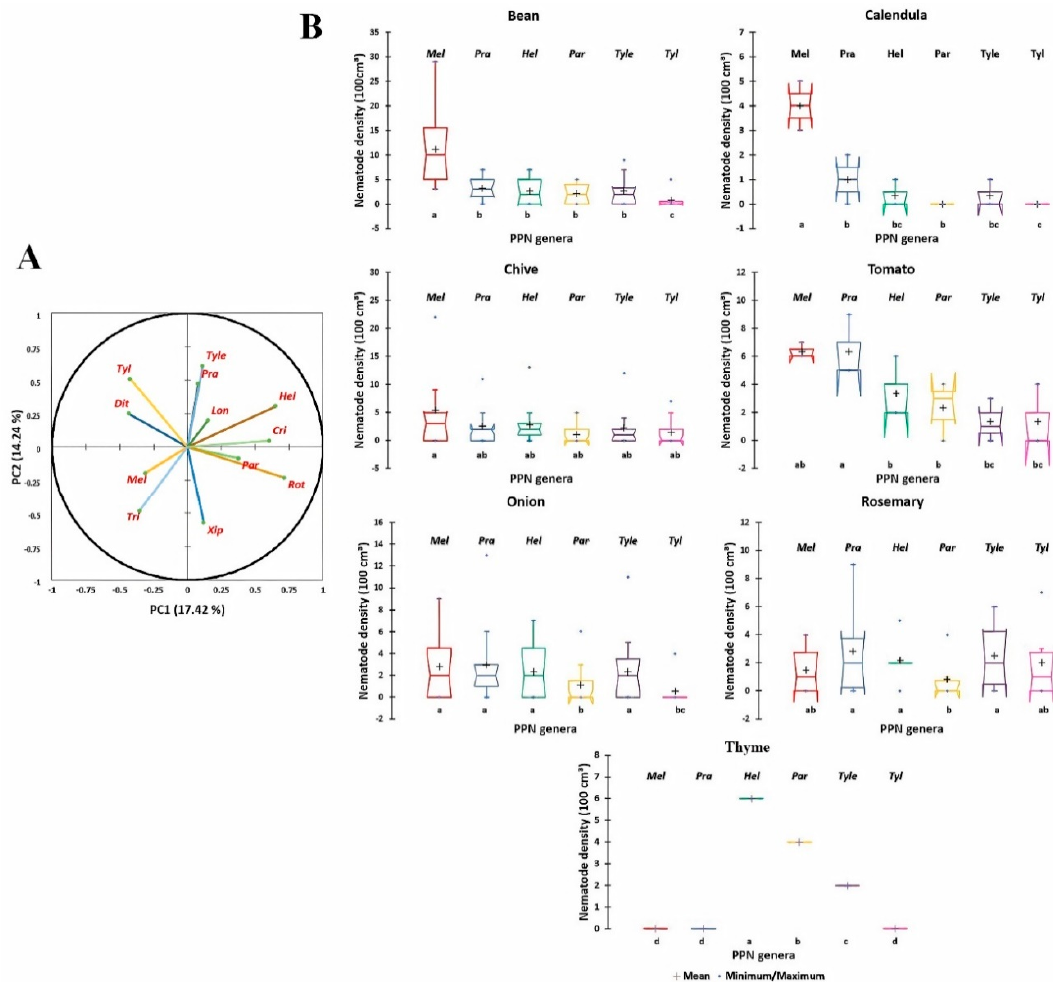
Figure 3. Plant-associated nematode community patterns in organic farming systems in Morocco. ( A ) PCA loading plot (Spearman type) for all nematode genera obtained in surveyed farming areas. ( B ) Notched box and whisker plots for the main PPNs identified for each organic crop. Nematode genera codes are given in Table 1. Letters represent homogeneous groups based on protected least significant difference test (LSD) for each variable at ( P < 0.001). Error lines on the bars represent the standard error ( n = 5).